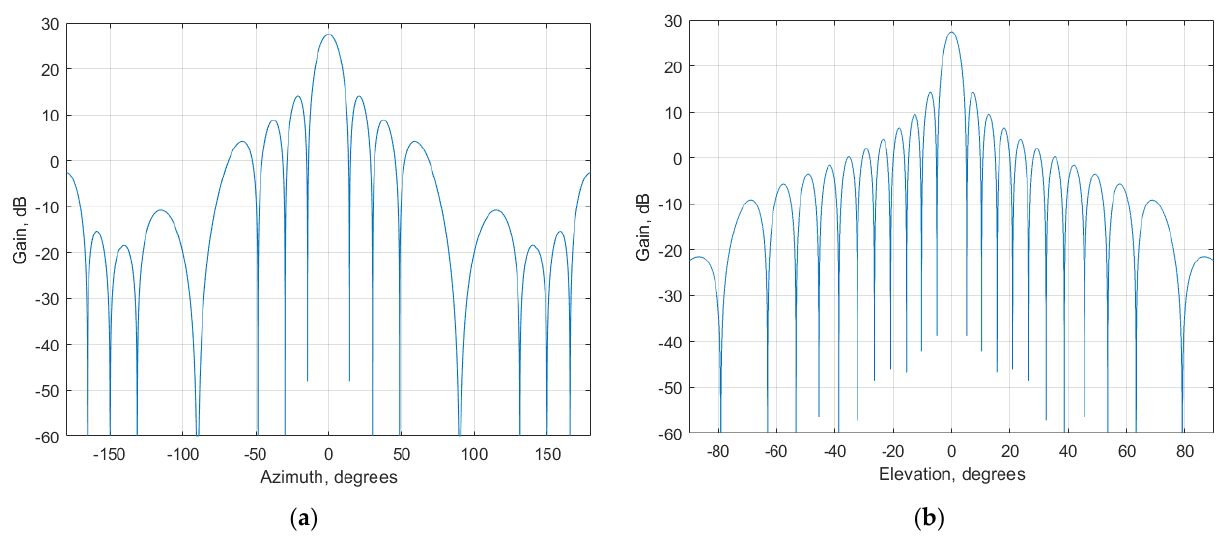
Figure 5. Antenna pattern of suburban 5G NR BS ( a ) Horizontal plane; ( b ) Vertical plane.